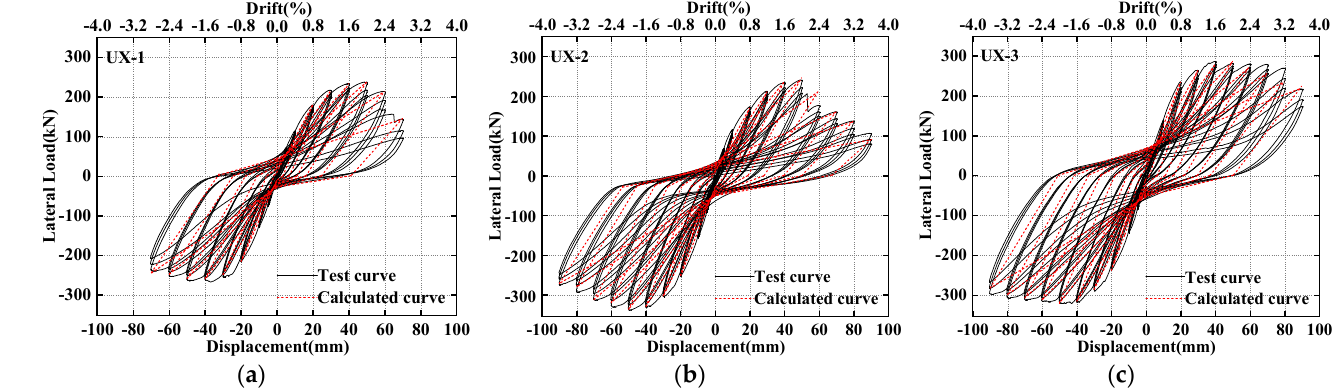
Figure 16. Comparison of hysteresis curves obtained by the restoring-force model and experiment: ( a ) Specimen UX-1; ( b ) Specimen UX-2; ( c ) Specimen UX-3.